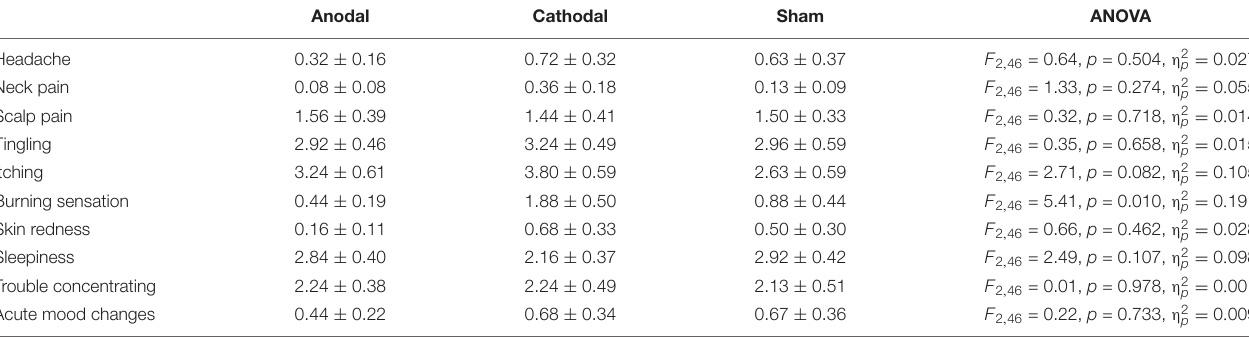
TABLE 2 | Reported adverse effects after anodal, cathodal, and sham HD-tDCS stimulation. Anodal Cathodal Sham